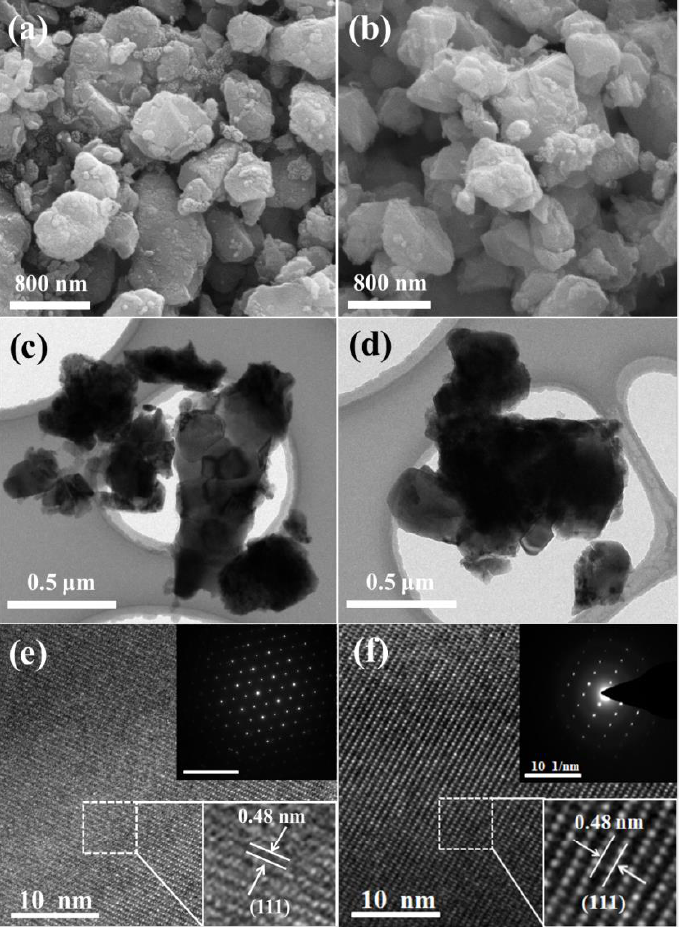
Figure 2. SEM images of ( a ) HLTO and ( b ) LTO; TEM images of ( c ) HLTO and ( d ) LTO; HRTEM images of ( e ) HLTO and ( f ) LTO. The insets in ( e , f ) show the SEAD patterns of the respective sample.